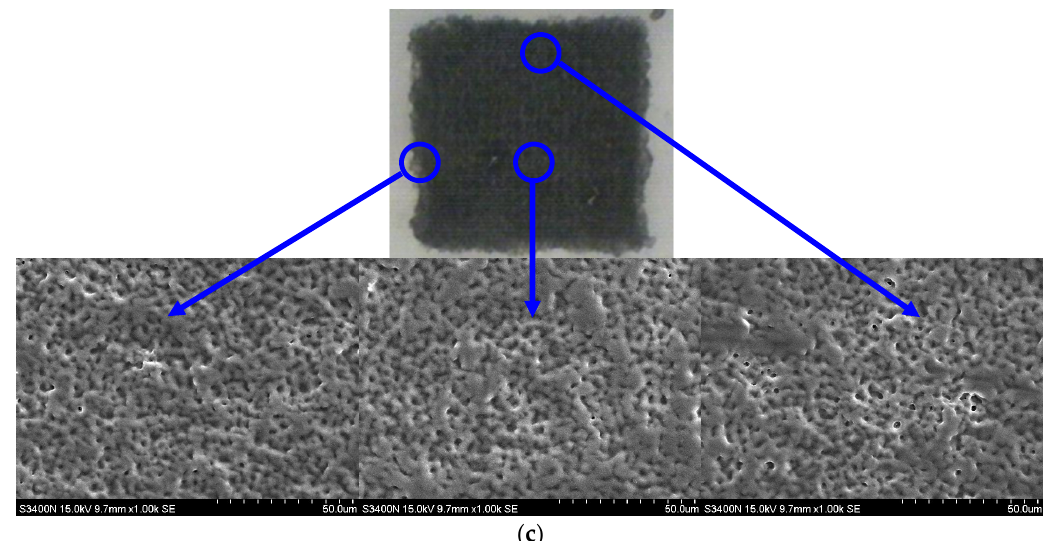
Figure 4. Optical photographs and surface morphologies of eight-layer CNT film with ( a ) unidirectional printing; ( b ) 180° rotation; ( c ) 90° rotation.